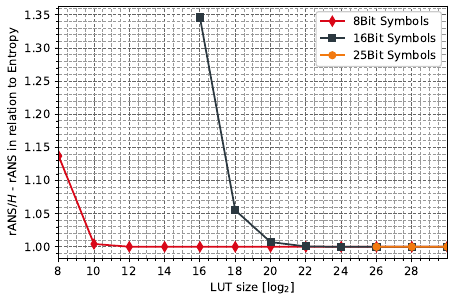
Figure 4: Relation between LUT precision and rANS encoding e ffi ciency.